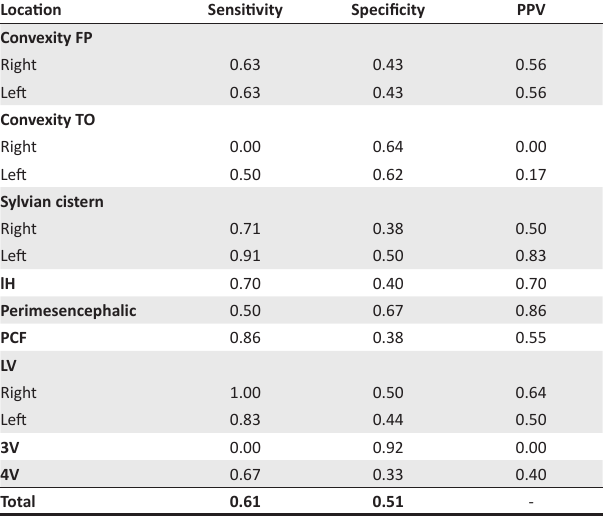
TABLE 3: Location-based sensitivity and specificity of SWI. Location